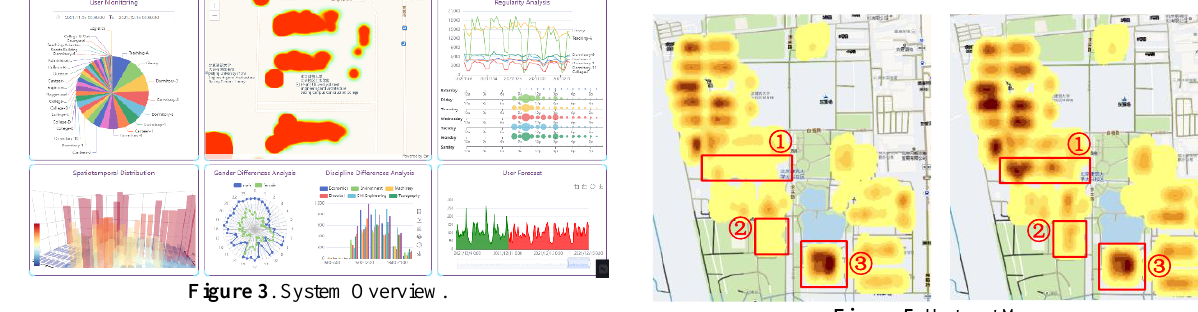
Figure 5 . Hotspot